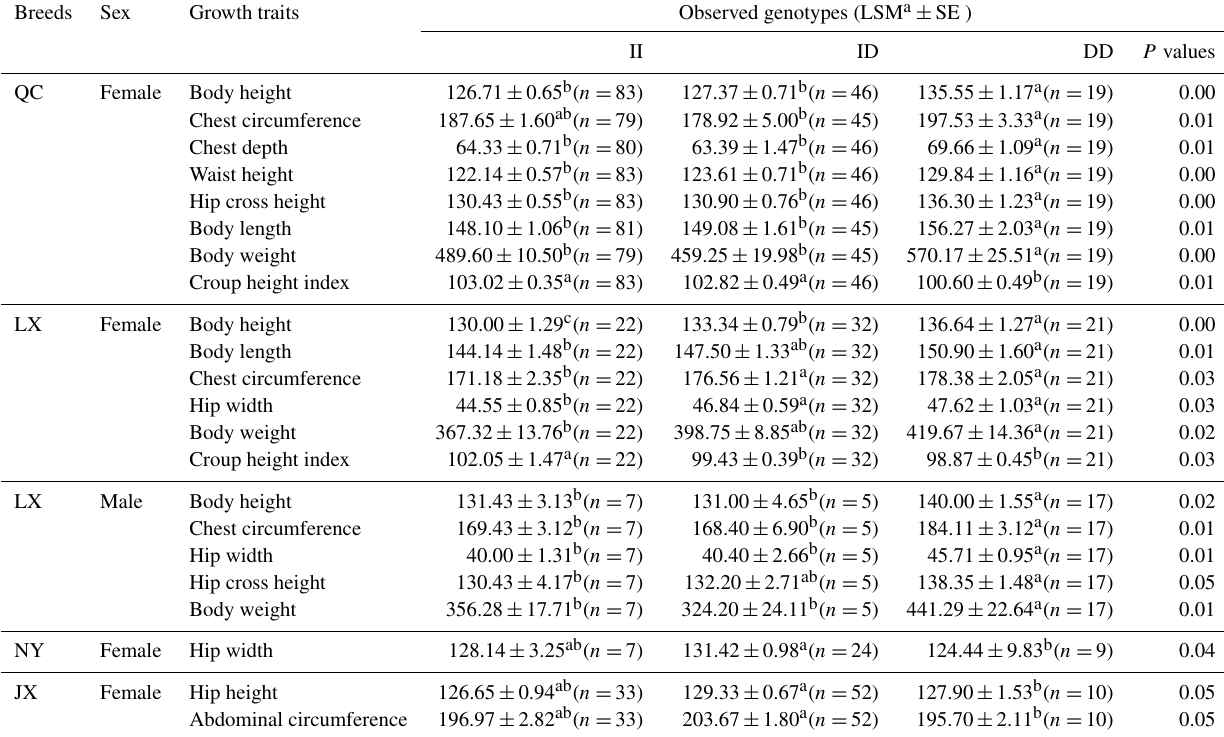
Table 4. Relationship between the novel 24bp indel of the cattle AR gene and growth traits in four cattle breeds. Breeds Sex Growth